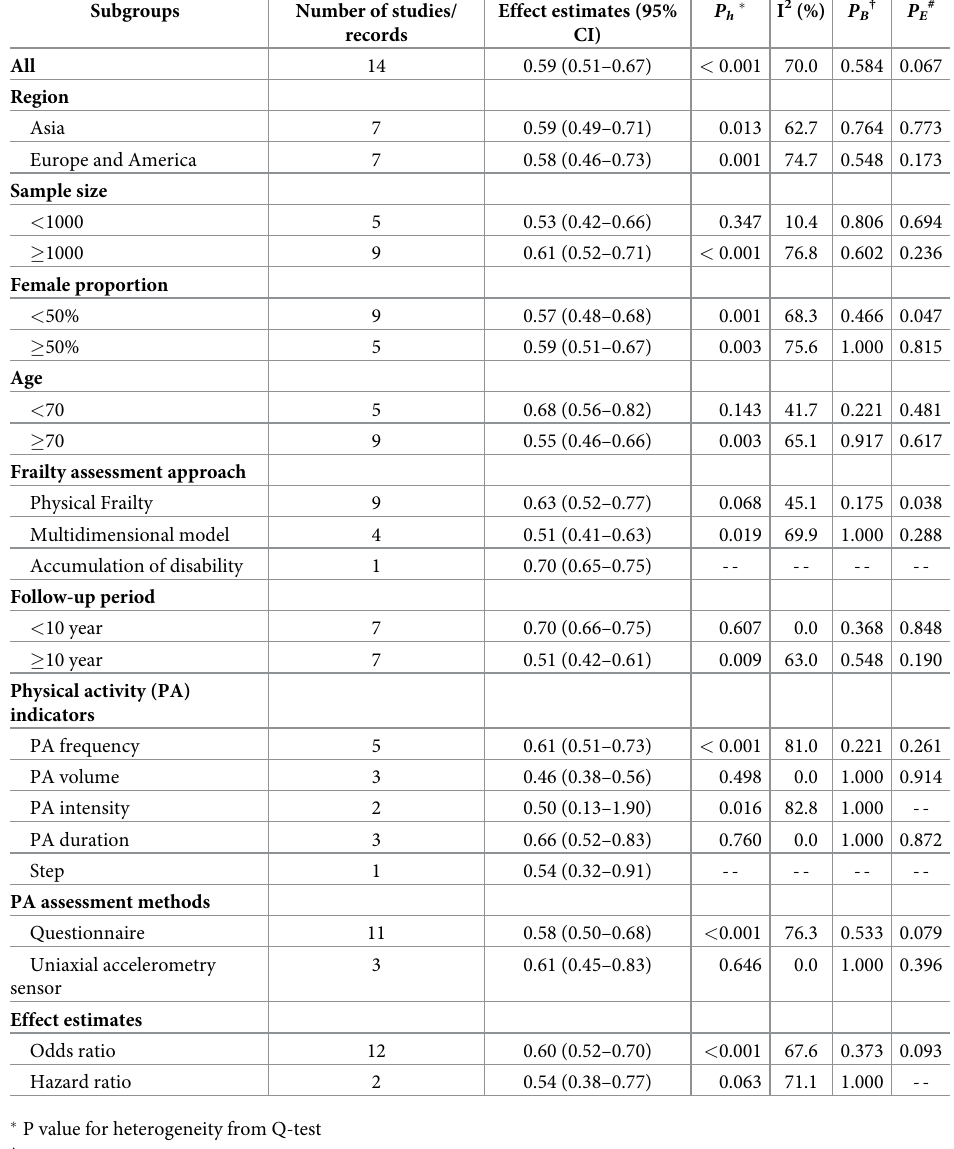
Table 2. Overall and subgroup meta-analyses on the association between physical activity and the risk of